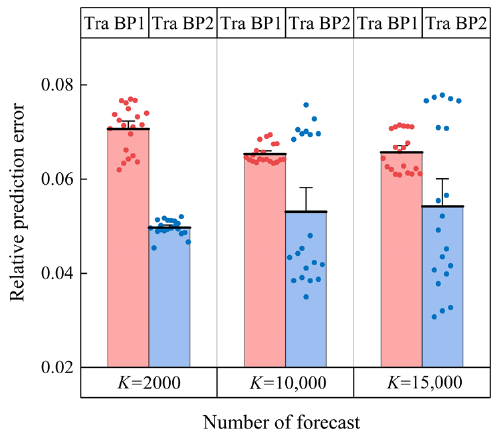
Figure 6. Influence of grinding wheel wear features on the prediction accuracy of the